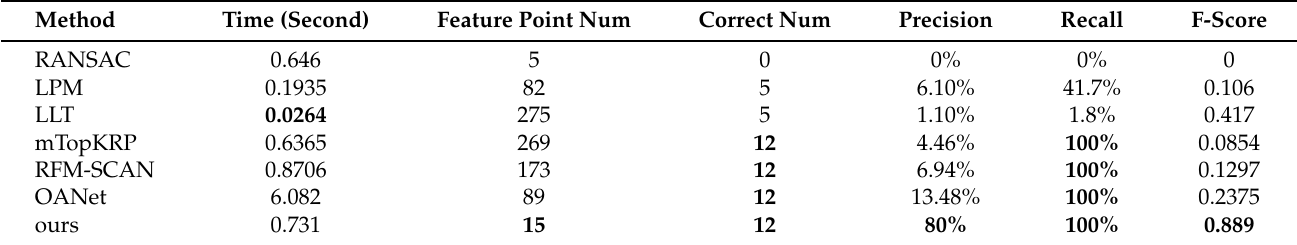
Table 2. Feature matching results of the seven methods for the OHS data. The registration results are evaluated using the four indicators: time, precision, recall, and F-score. The best results are marked in